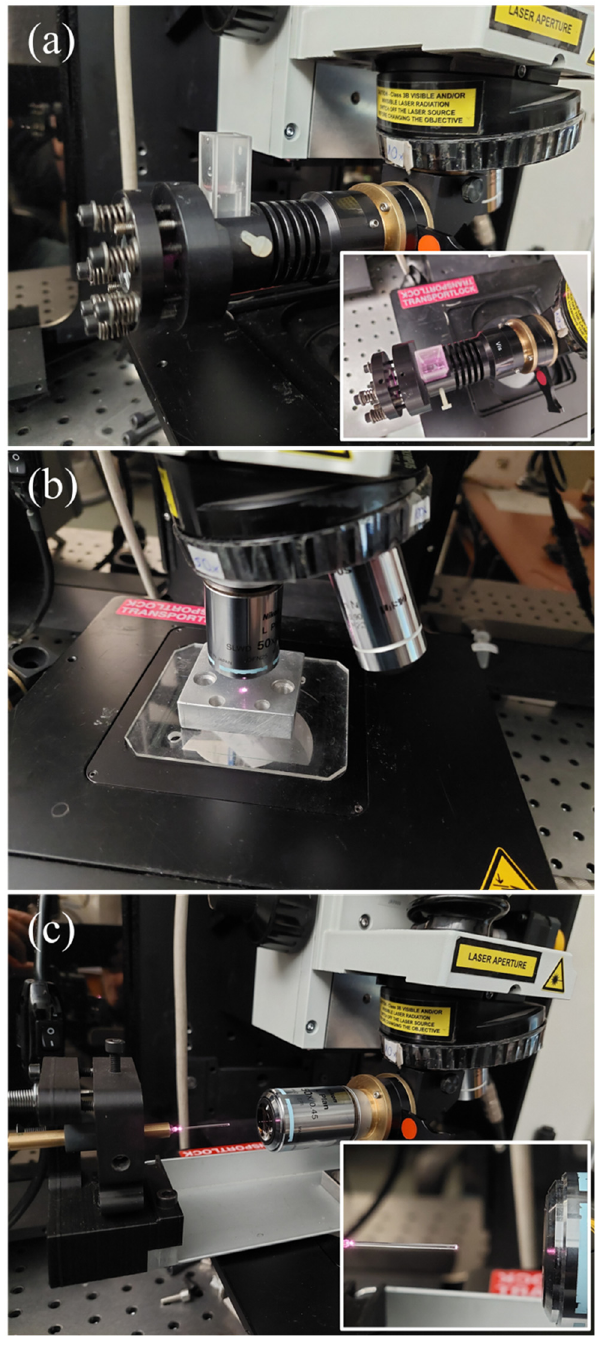
Figure 1. Different backscattering geometries for the excitation/collection of Raman spectra of liq- uids in μ -Raman instruments: ( a ) accessory mounted in place of an objective, permitting the use of typical quartz cuvettes, ( b ) proposed simple arrangement of a container made by drilling a blind hole in a metallic block, ( c ) proposed geometry based on the use of a capillary tube to avoid evapo- ration.